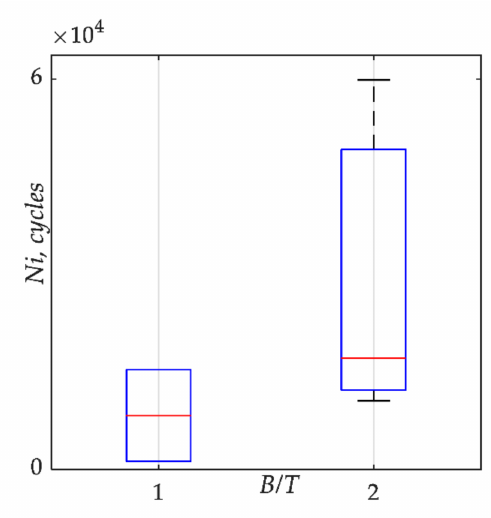
Figure 11. Boxplot for number of cycles to crack initiation Ni values including bending/torsion moment ratio B/T